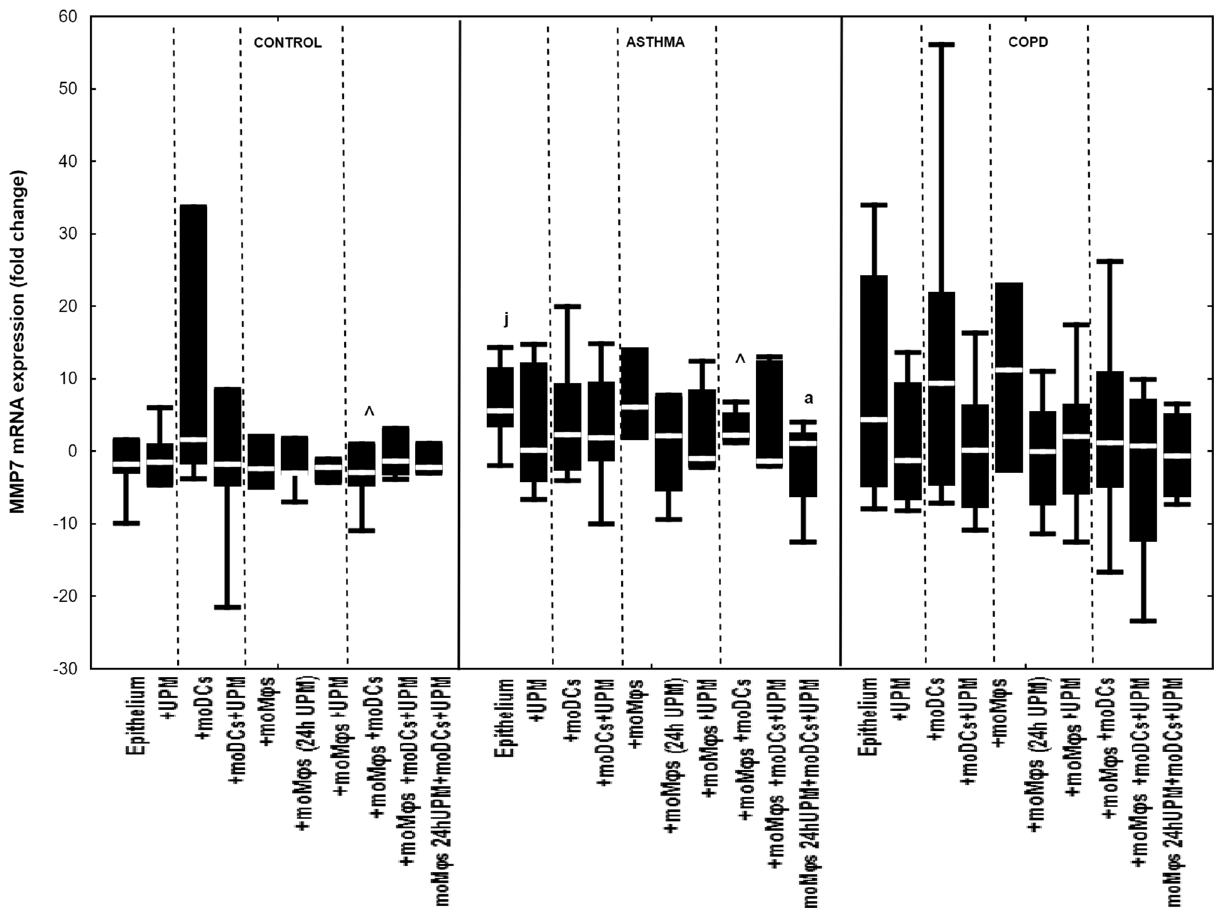
Figure 5. MMP7 mRNA expression in air–liquid interface (ALI) after 24 h UPM exposure in multi co-culture schemes in control subjects, asthma and COPD patients. The data are shown as non-outlier range (whiskers), interquartile range (box) and median (line); p value calculated using Mann–Whitney U test. The p value < 0.05 in comparison to: a—epithelium, b—epithelium + UPM, c—epithelium + moDCs, d—epithelium + moDCs + UPM, e—epithelium + moMφs, f—epithelium + moMφs (24 h UPM), g— epithelium + moMφs + UPM, h—epithelium + moMφs + moDCs, i—epithelium + moMφs + moDCs + UPM, j—epithelium + moMφs (24hUMP) + moDCs + UPM; ^ asthma versus control, # COPD versus control, *asthma versus